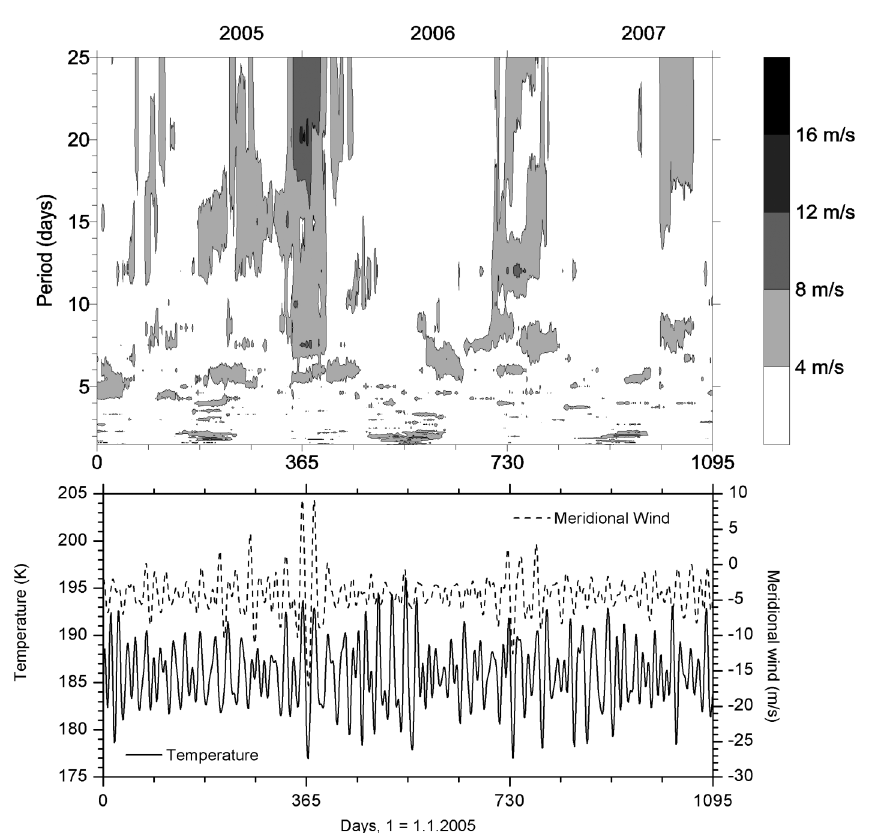
Fig. 5. Upper panel: Meridional wind amplitude spectra at 88 km altitude, measured with the Collm SKiYMET radar. Lower panel: 10-30 days bandpass filtered meridional wind at 88 km and temperatures at 90